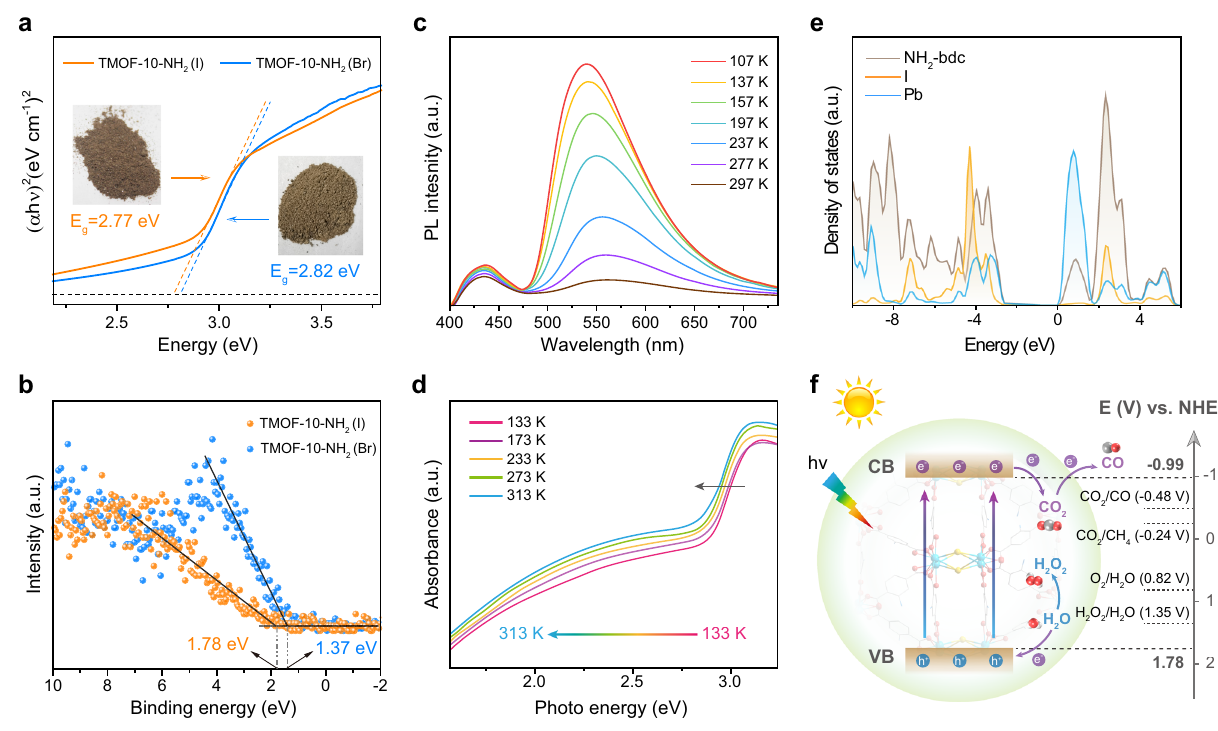
Fig. 3 | Photophysical properties of TMOF-10-NH 2 . a Estimated band gaps of TMOF-10-NH 2 (I) and TMOF-10-NH 2 (Br) by UV-Vis absorption spectra. b VB-XPS spectra of TMOF-10-NH 2 (I) and TMOF-10-NH 2 (Br). c Temperature-dependent emission spectra of TMOF-10-NH 2 (I) from 107K to 297K. d